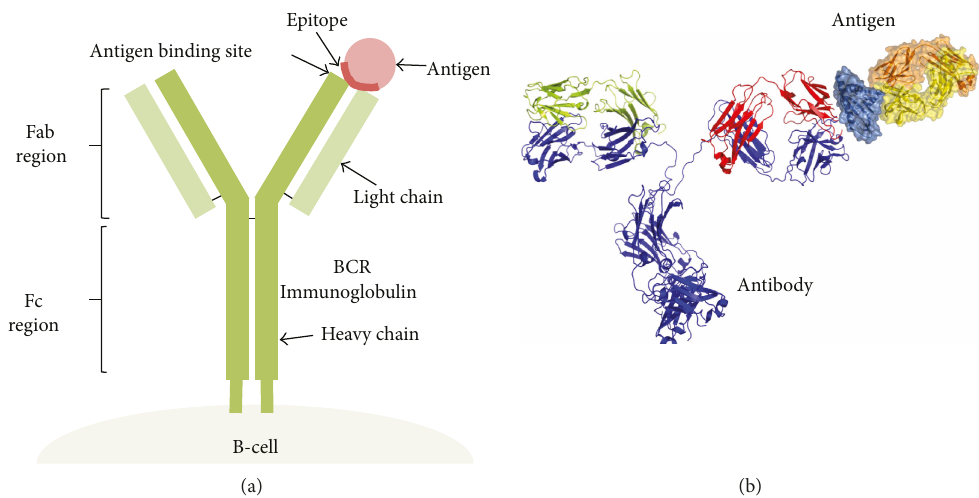
Figure 1: B-cell epitope recognition. B-cell epitopes are solvent-exposed portions of the antigen that bind to secreted and cell-bound immunoglobulins. (a) B-cell receptors encompass cell-bound immunoglobulins, consisting of two heavy chains and two light chains. The di ff erent chains and regions are annotated. (b) Molecular representation of the interaction between an antibody and the antigen. Antibodies are secreted immunoglobulins of known speci fi